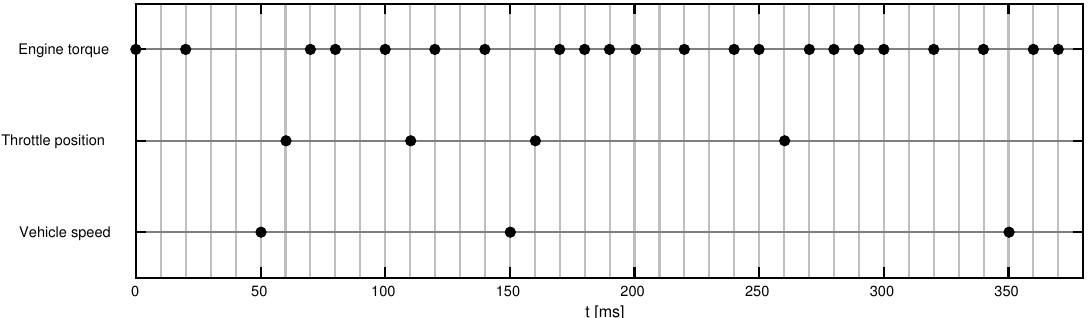
Figure 6. Timestamps for some representative CAN variables in one of the driving